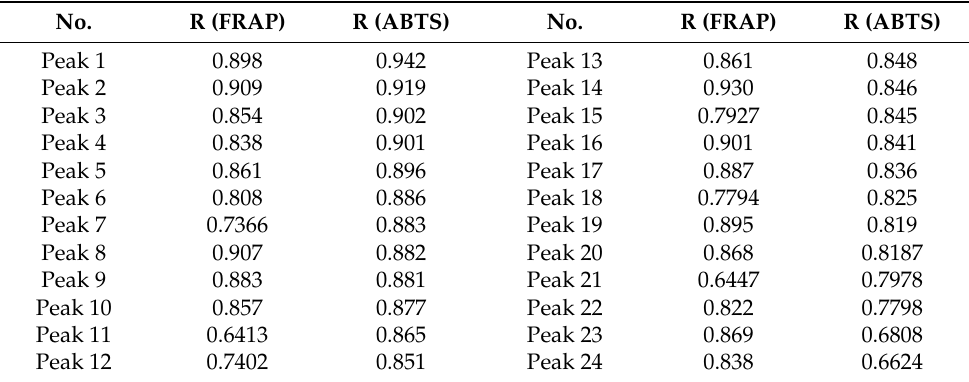
Table 5. Gray relational analysis results between variables and antioxidant activity data. No. R (FRAP) R (ABTS)